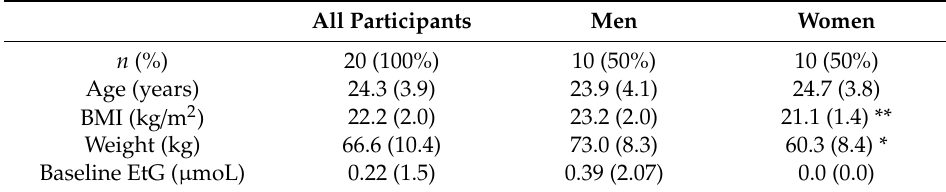
Table 3. Description of study